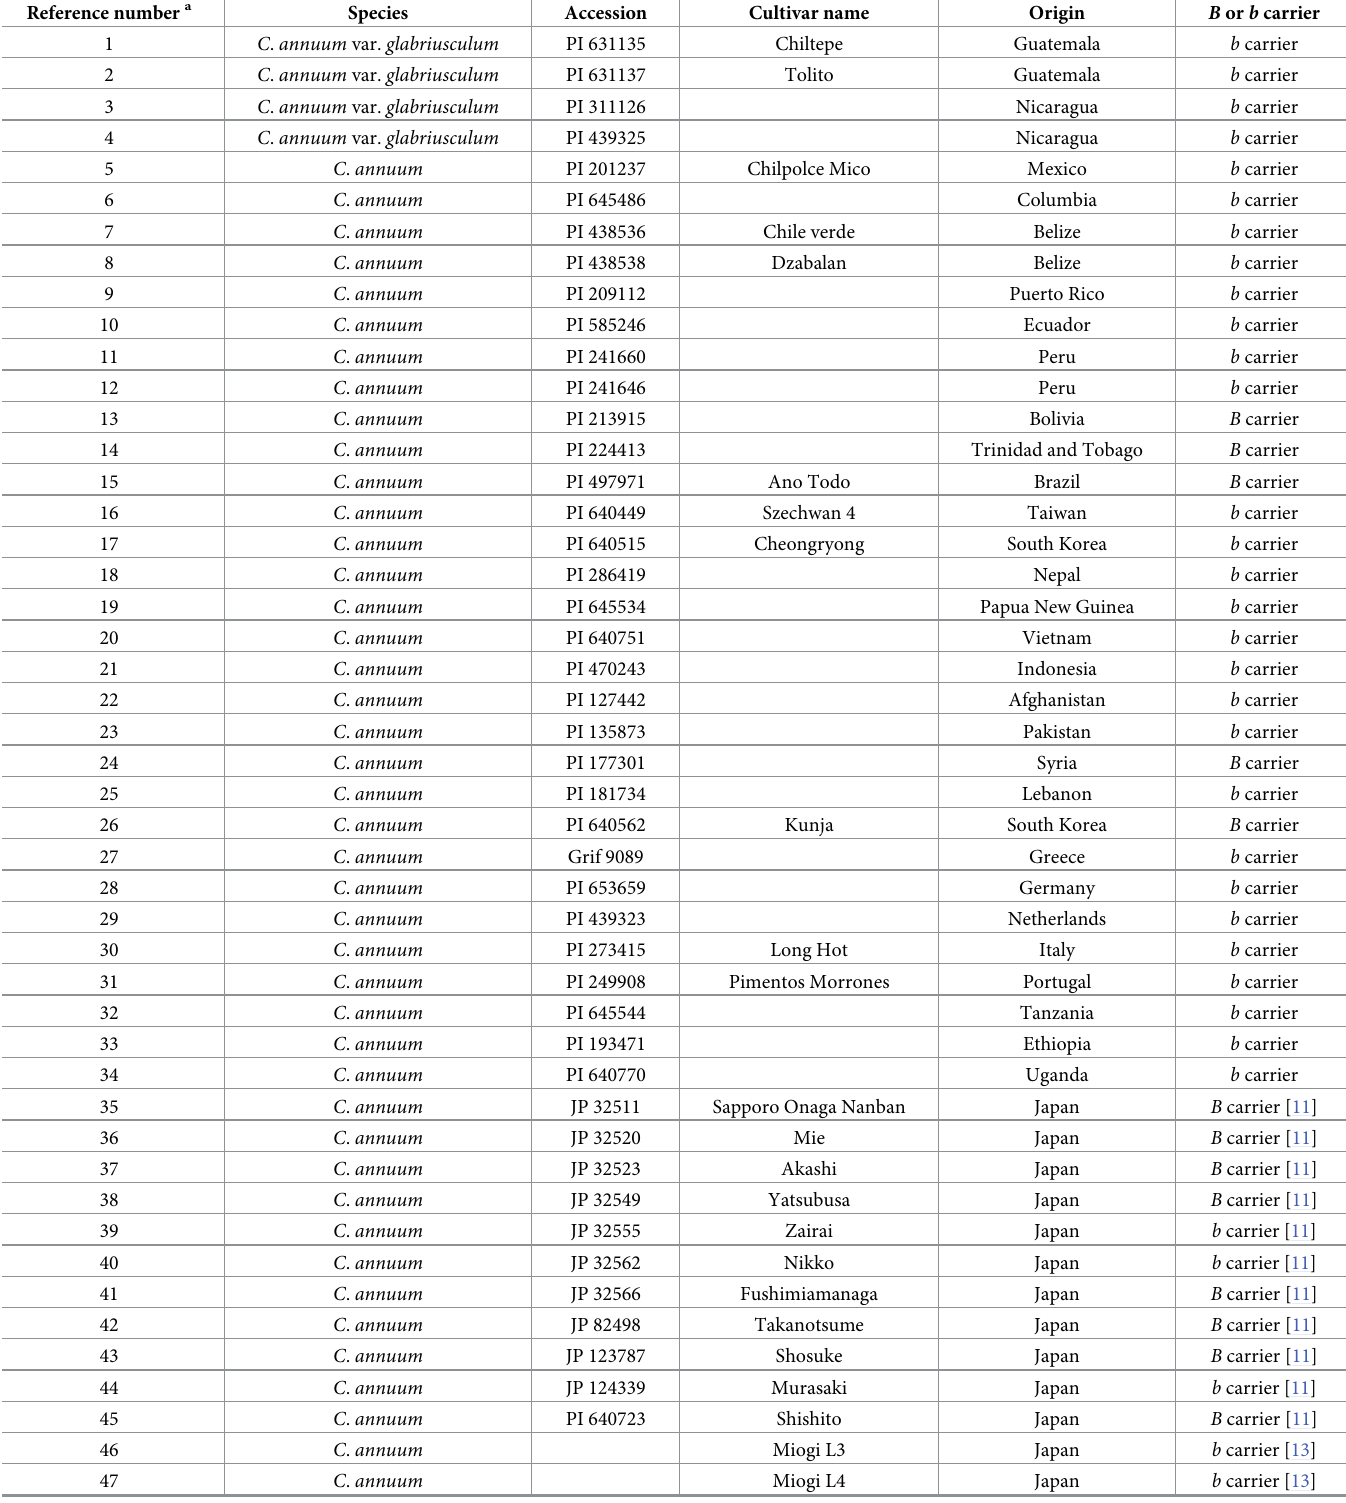
Table 1. Plant materials used for SSR